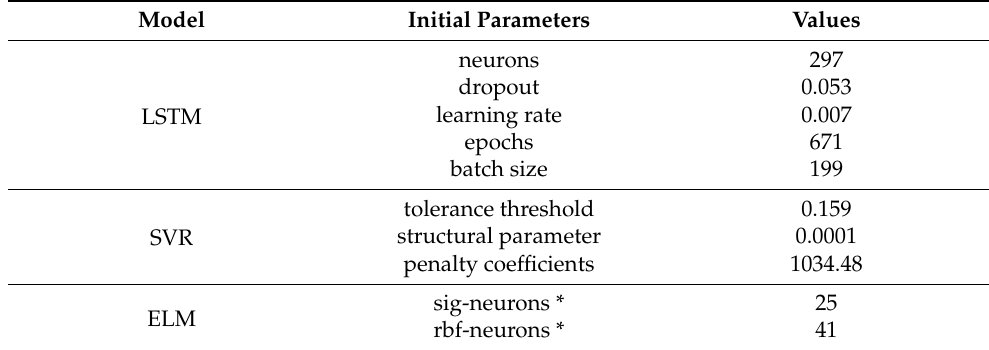
Table 2. Optimized values of the ML